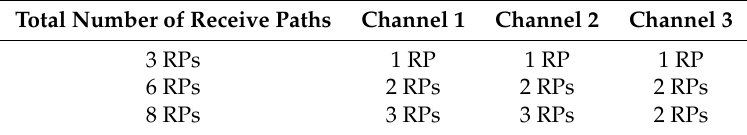
Table 7. Receive paths assigned to the 3 default